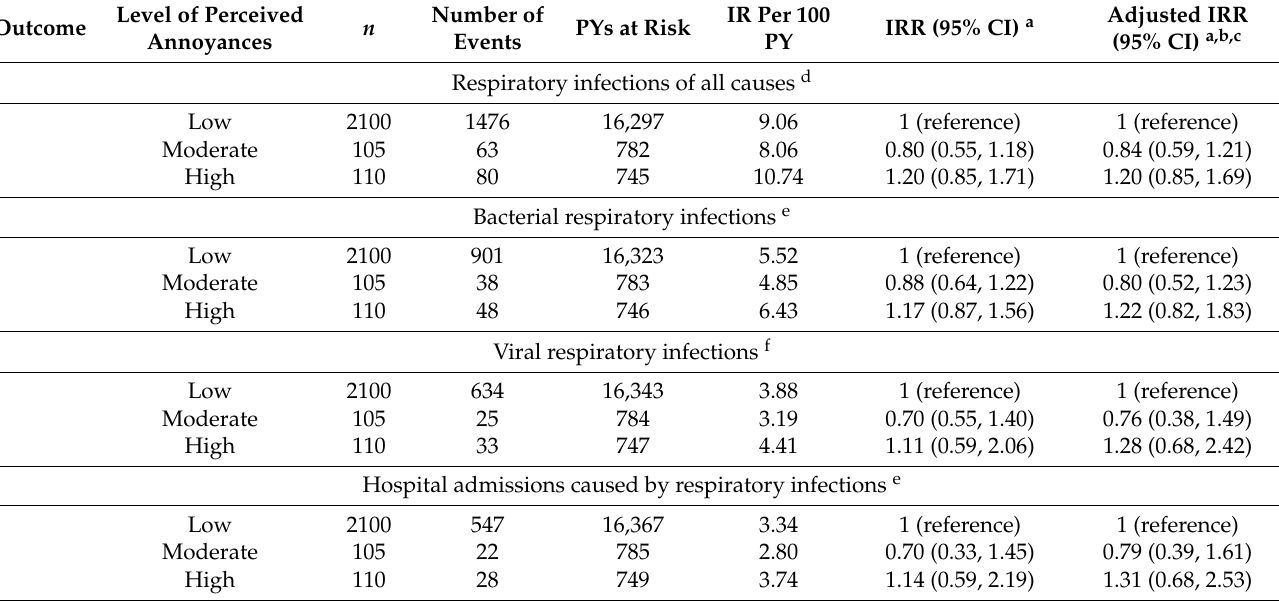
Table 3. Poisson regression of rates of recurrent respiratory infection among participants with asthma or COPD from the Danish Health and Morbidity Survey